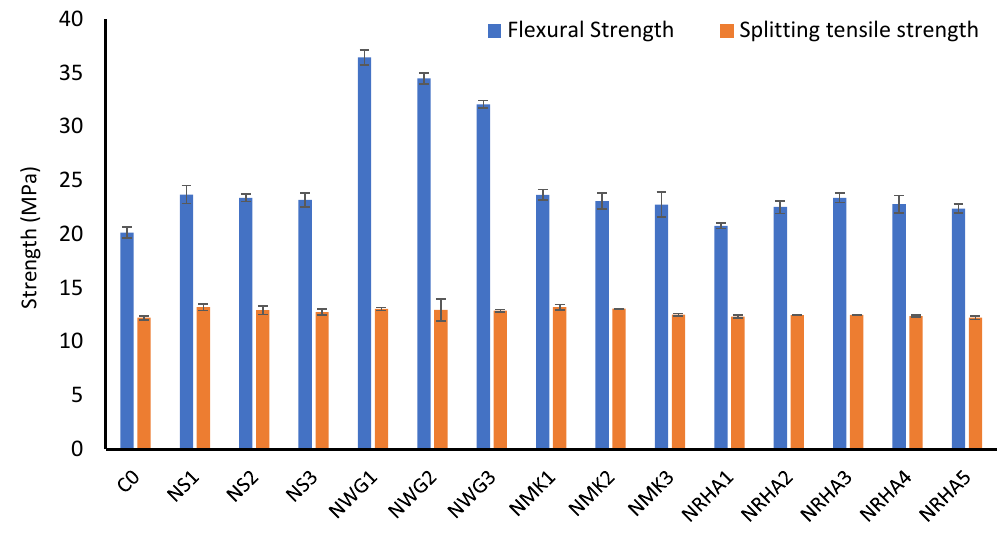
Figure 7. Flexural and tensile strength of UHPC at 28 days.